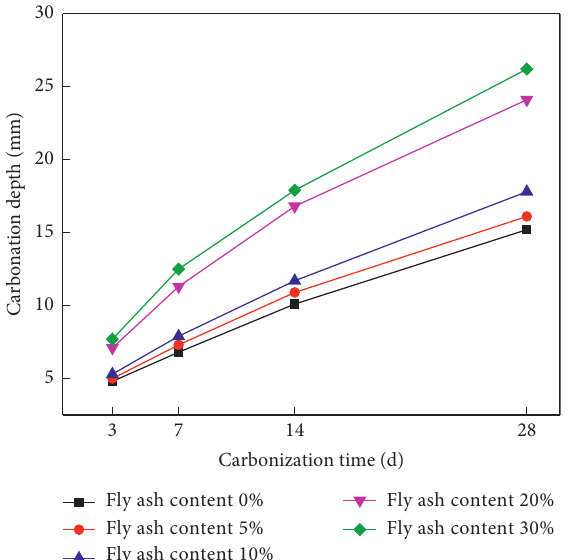
Figure 6: Relationship between carbonation depth and time of hybrid fiber fly ash